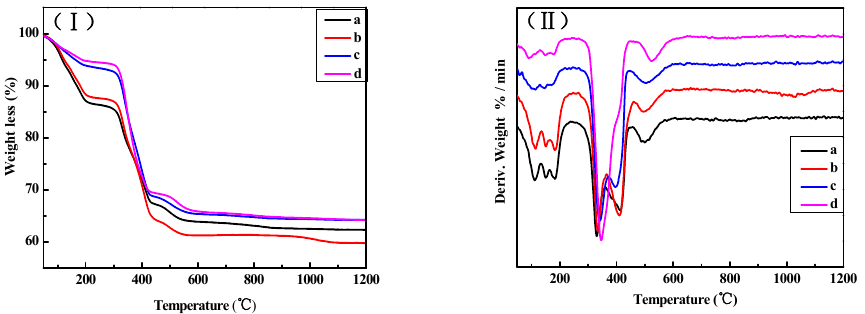
Figure 13. TG curves ( Ⅰ ) and DTG curves ( Ⅱ ) of the inner cores of the MOC samples after different dry–wet cycles: (a) without dry–wet cycles; (b) one time; (c) two times; (d) three times.